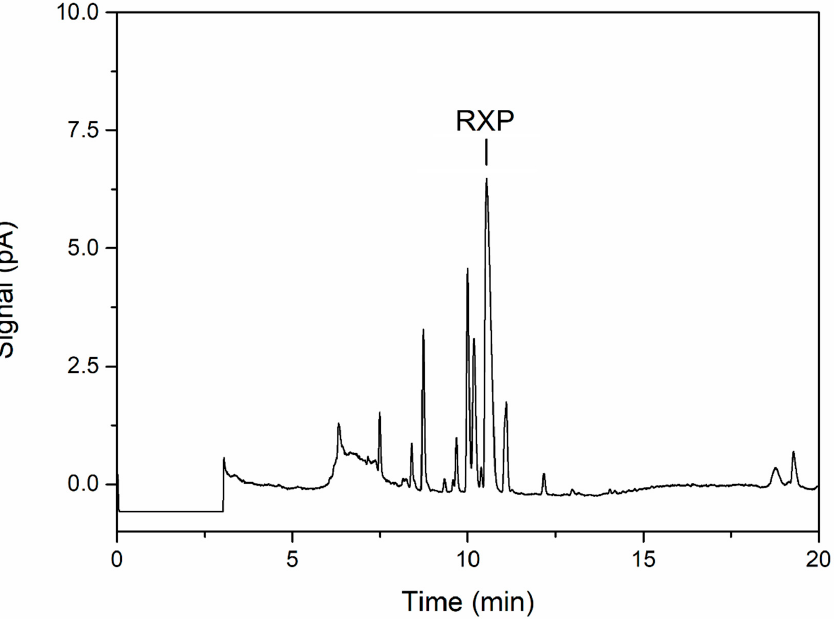
Figure 3. UHPLC chromatogram of the fermentation supernatant showing the main product (RXP) and byproducts (three peaks to the left of RXP) of VietABC.